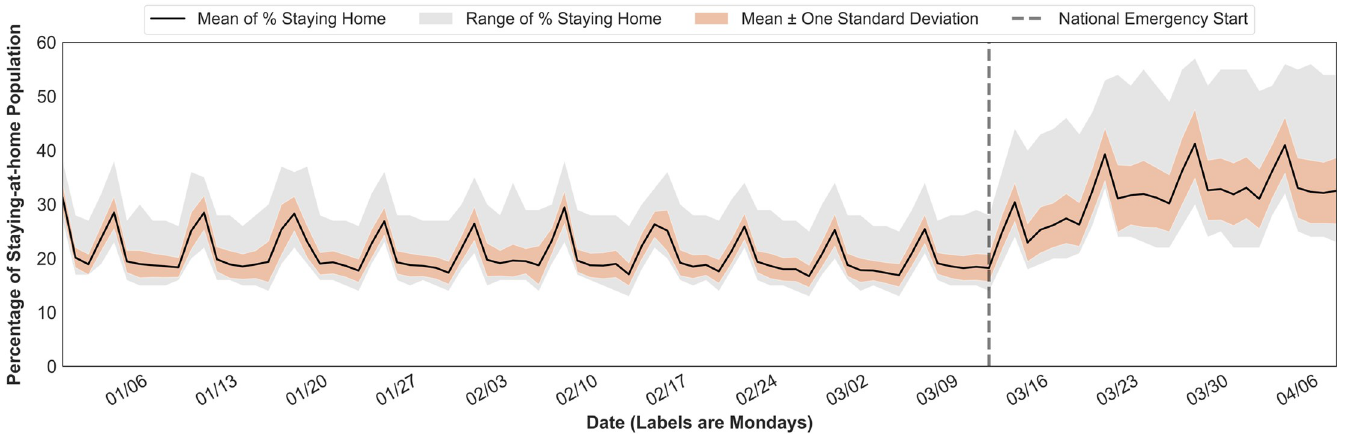
Fig 5. Temporal variations on the percentage of people staying home for all